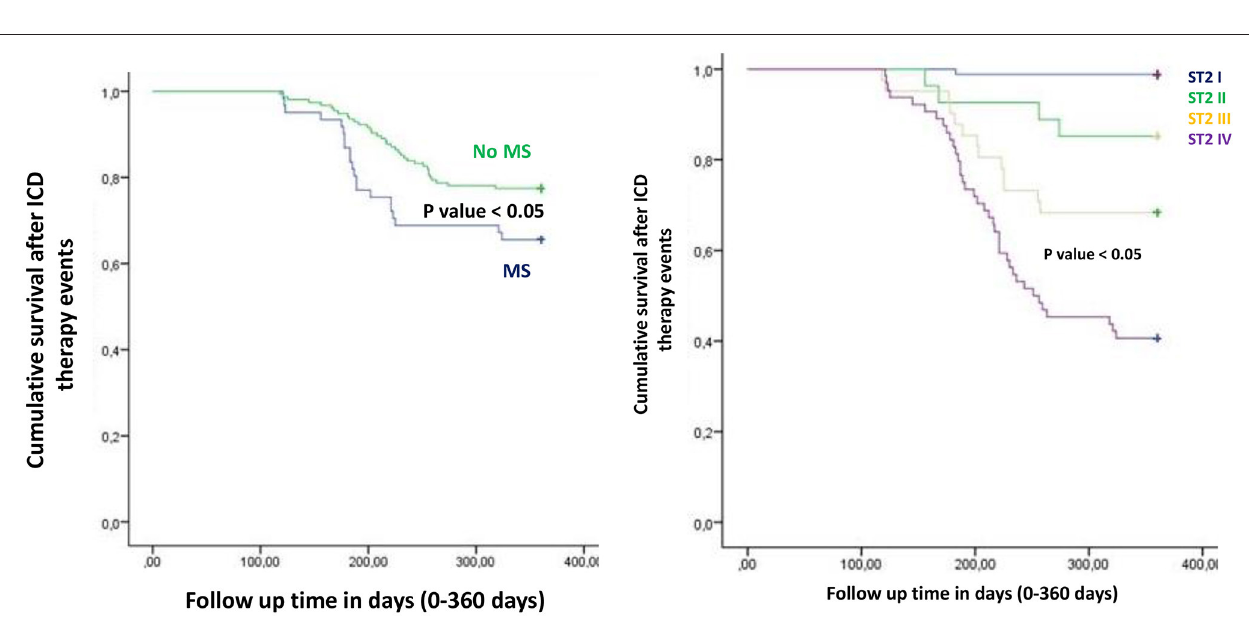
FIGURE 6 | The curve representation of “cumulative survival from ICD inappropriate therapy events” (on y axis) during 360 days follow up (on x axis) comparing MS vs. no MS patients (left part), and different quartiles (right